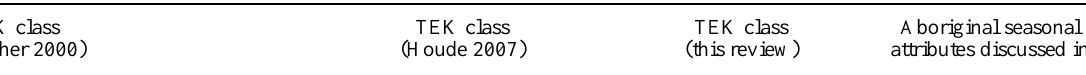
Table 1. Adaptation of traditional ecological knowledge (TEK) classification systems as used to structure our review. Numbering refers to the class numbers used by the authors indicated and by us. Classes from Usher (2000), Houde (2007), and our classification are grouped together in rows to indicate their approximate